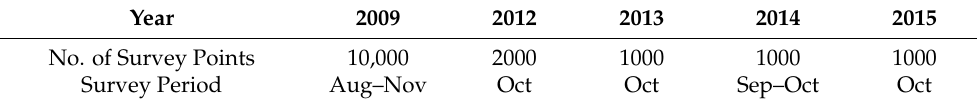
Figure 2. Monthly temperature change in Seoul (2009). Table 2. Survey points and survey periods of Pedestrian Volume Surveys (PVSs).